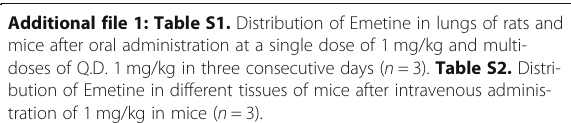
Additional file 1: Table S1. Distribution of Emetine in lungs of rats and mice after oral administration at a single dose of 1 mg/kg and multi- doses of Q.D. 1 mg/kg in three consecutive days ( n = 3). Table S2. Distri- bution of Emetine in different tissues of mice after intravenous adminis- tration of 1 mg/kg in mice ( n =